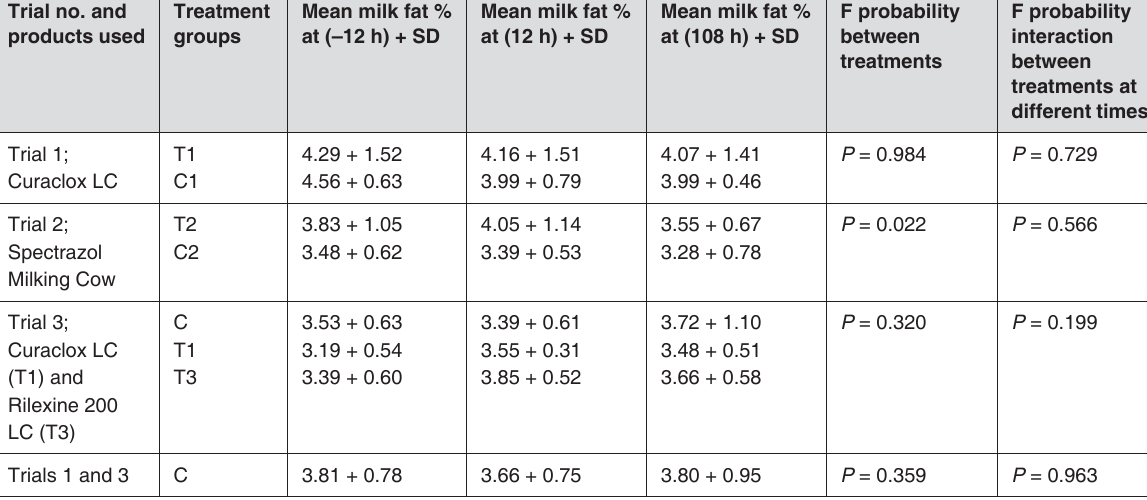
TABLE 3 Milk fat percentages for treatment (T1, T2 and T3) and control groups of goats. (Analysis of an unbalanced design) Trial no. and products used